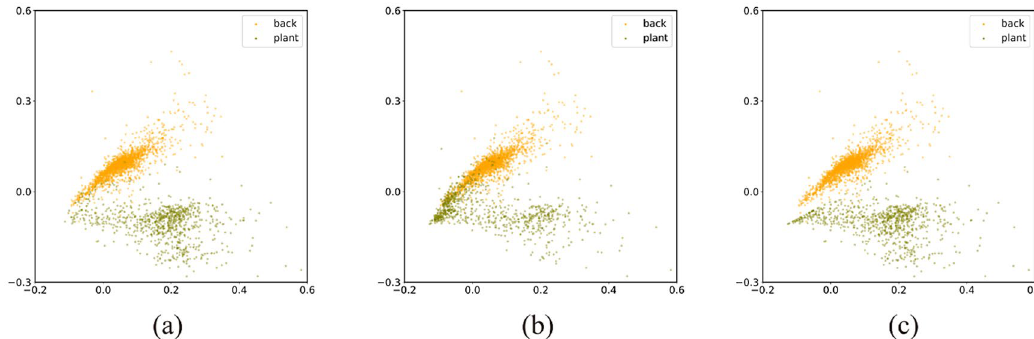
Figure 9. Distribution of data in two-dimensional feature space according to different labelling methods. ( a ) PLFL, ( b ) MGRL, ( c ) CDTL. Here, ‘back’ stands for background (soil, weeds, etc.) and ‘plant’ stands for foreground (bean